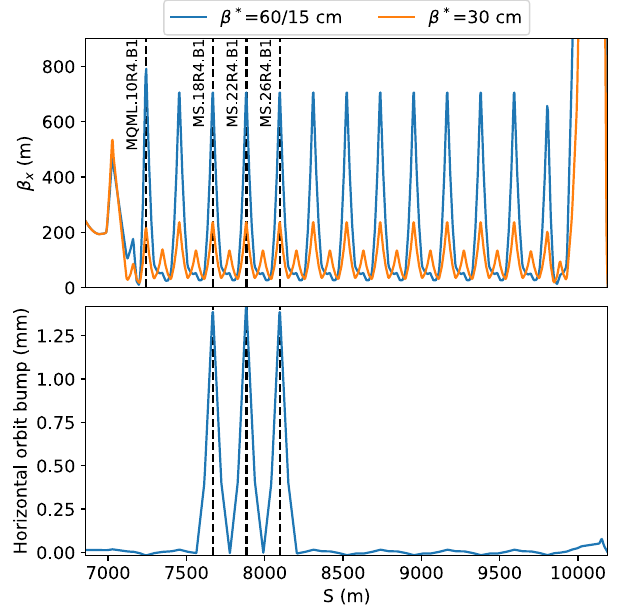
FIG. 17. The top plot shows the design horizontal β -function from IP4 to IP5 for β (cid:1) ¼ 60 = 15 cm flat optics and for β (cid:1) ¼ 30 cm, the nominal 2018 optics. The ATS optics scheme increases the β -function in this arc by a factor of 4. The bottom plot shows the horizontal orbit bump implemented in the sextu- poles to correct the optics via feed-down.